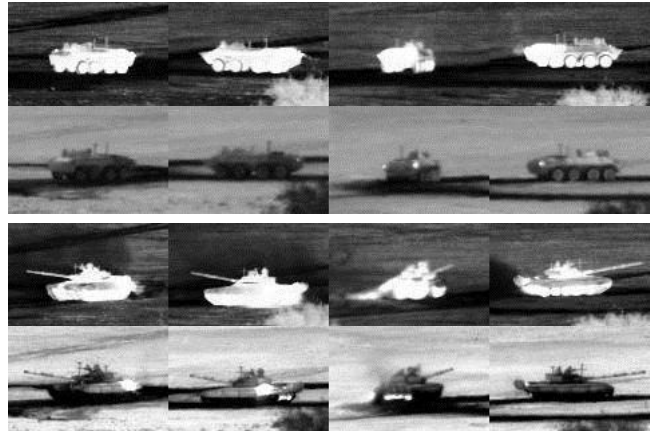
Figure 1. Examples of target signature variability from the Military Sensing Information Analysis Center (SENSIAC) ATR database [5]. The first and second rows show diurnal and nocturnal mid-wave IR (MWIR) images of a BTR70 personnel carrier, respectively. The third and fourth rows are diurnal and nocturnal images of a T72 main battle tank. Targets in each column are under the same